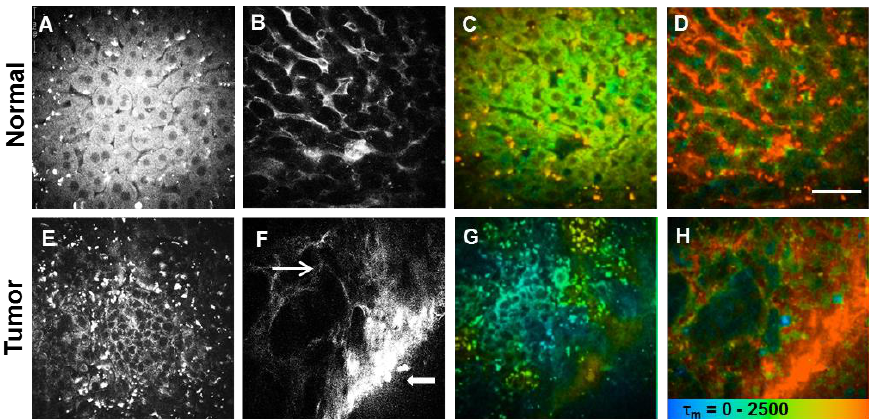
Figure 3. Multiphoton microscopy coupled with fluorescence lifetime imaging (MPM-FLIM) images of normal liver tissue and hepatocellular carcinoma after QDs injection. Narrow arrow indicates disordered and tortuous vasculature of hepatocellular carcinoma with inefficient blood perfusion and filled arrow indicates larger vessels connected to the tumor vasculature. ( A , E ) Fluorescence intensity image recorded at λ Exc /λ Em : 740/350 to 450 nm; ( B , F ) Fluorescence intensity image recorded at λ Exc /λ Em : 900/515 to 620 nm; ( C , G ) Pseudocolored fluorescence lifetime image (τ m : 0 – 2500 ps; blue-green-red) recorded at λ Exc /λ Em : 740/350 to 450 nm or ( D , H ) recorded at λ Exc /λ Em : 900/515 to 620 nm. (Scale bar: 40 μm).